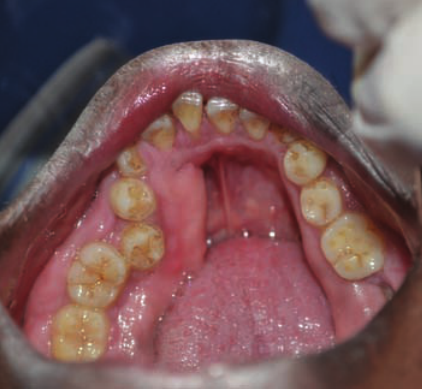
Figure 8: Clinical picture showing gingival enlargement and mal- occlusion.